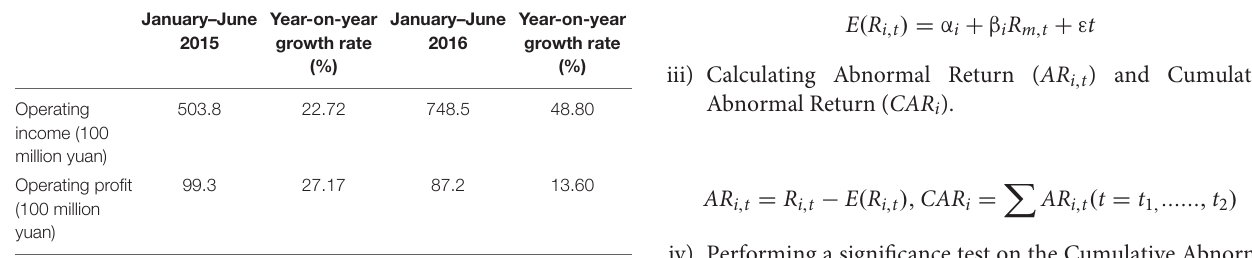
TABLE 2 | Profits of Vanke in the first half of